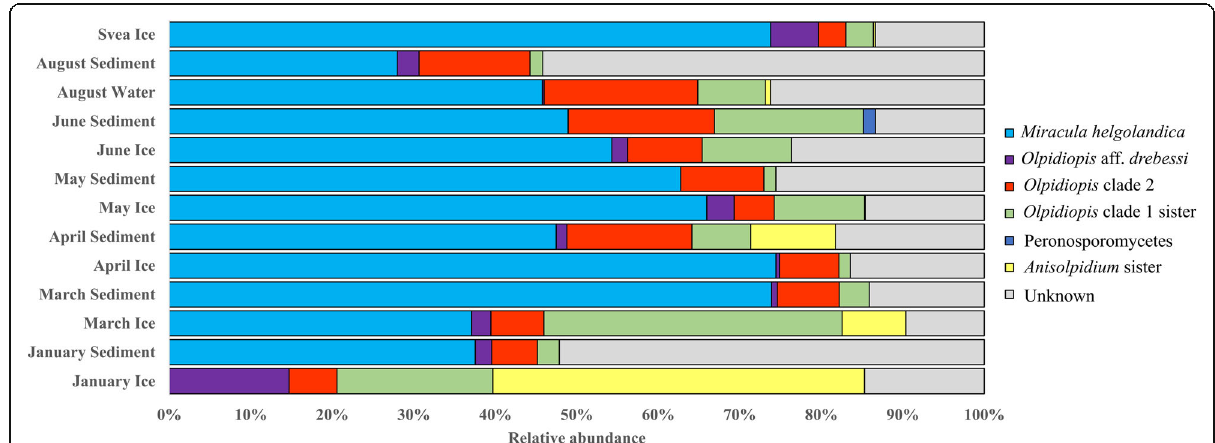
Fig. 3 Seasonal relative abundance of the top 100 Oomycota V3-V4 OTUs detected in Barrow, Alaska, as well as one site in Svea, Svalbard (May of the same year). The classification scheme corresponds to phylogenetic position of 18S rRNA V3-V4 OTUs, as these sequences were unidentifiable with a Bayesian classification